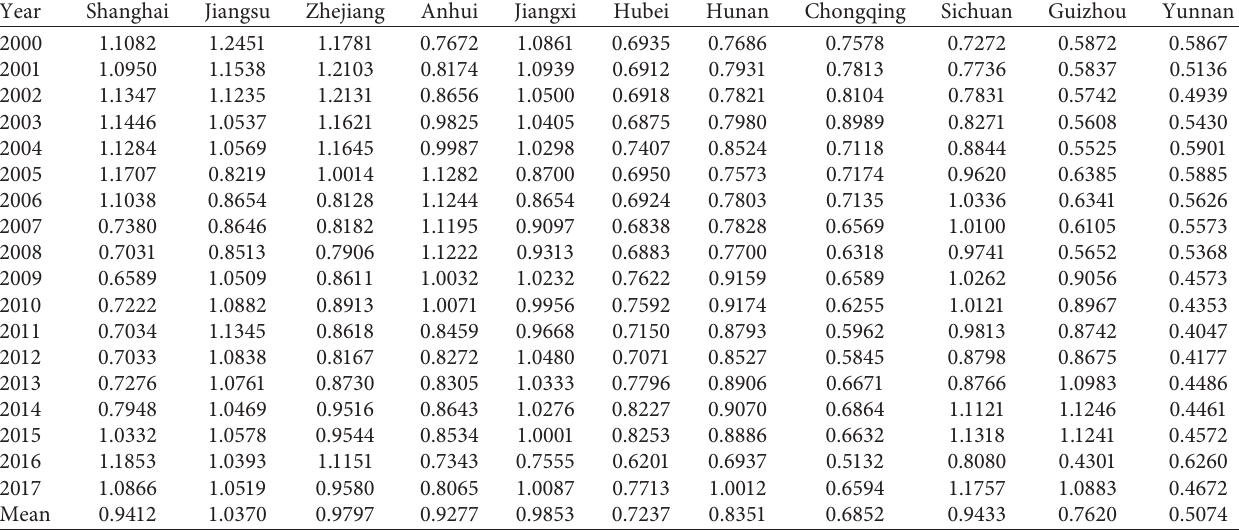
Table 3: Provincial TIEEs in